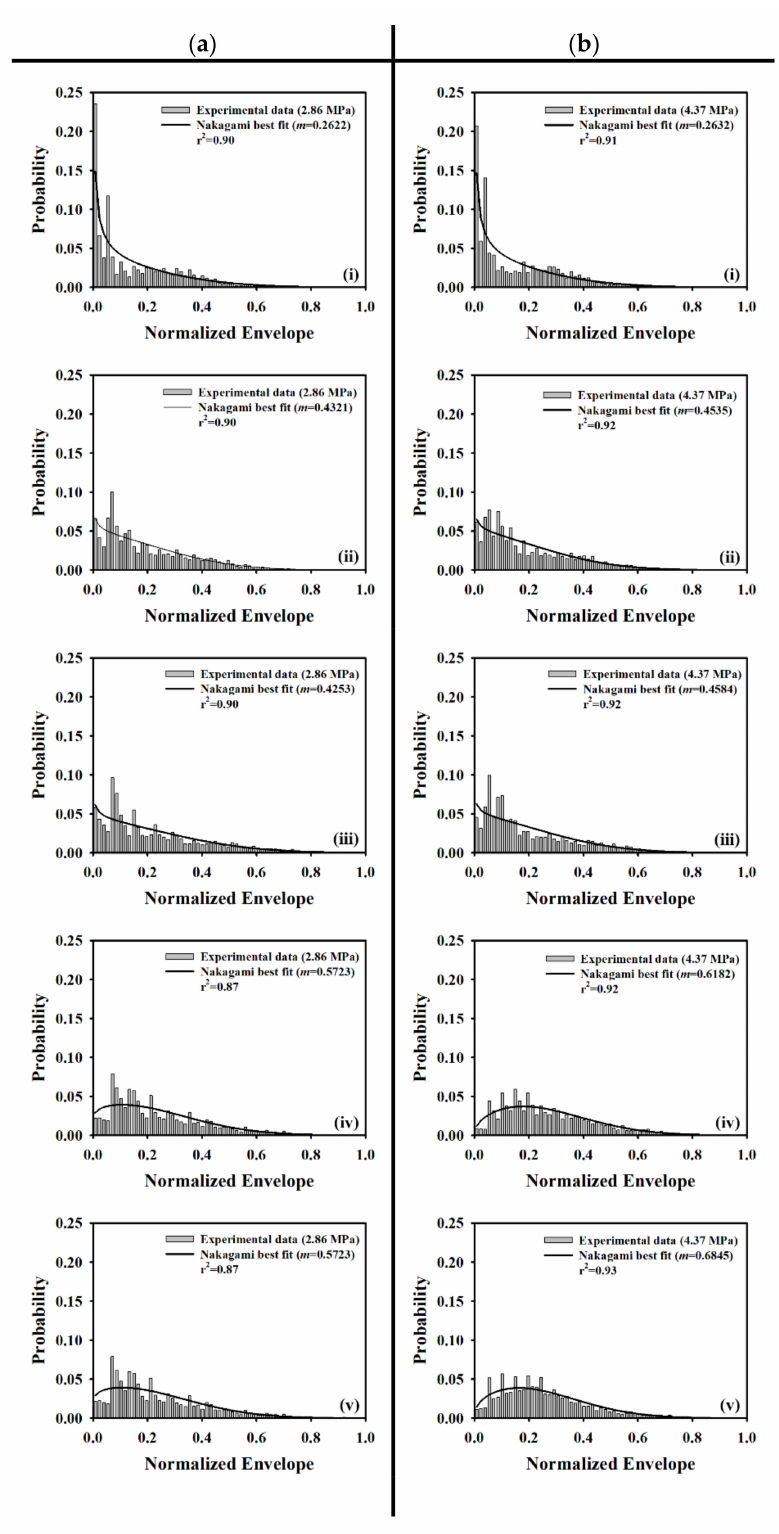
Figure 7. Typical probability density functions (PDFs) and fitted Nakagami distribution corresponding to the incidence of ( a ) 2.86 and ( b ) 4.37 MPa acoustic pressures into the flow phantom in which UCAs of various concentrations of (i) 0, (ii) 6.7, (iii) 13.3, (iv) 26.7, and (v) 53.3 × 10 6 UCAs / mL were